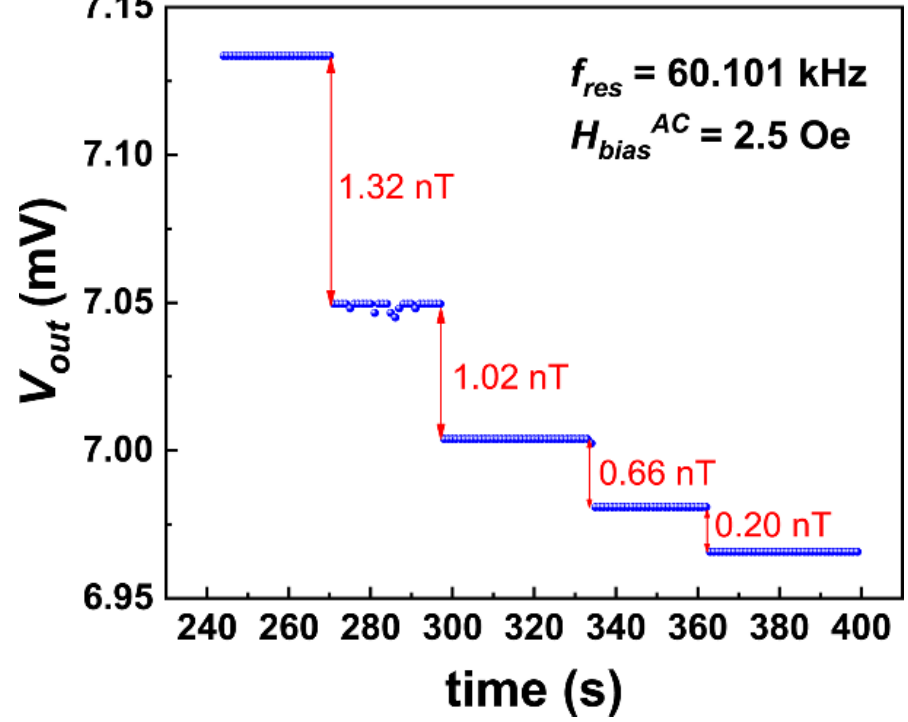
Figure 4. AC magnetic field resolution at 𝑓 𝑟𝑒𝑠 of 60.101 kHz and 𝐻 𝑏𝑖𝑎𝑠𝐴𝐶 of 2.5 Oe. Similarly, DC field resolution 𝐻 𝑟𝑠𝑙𝐷𝐶 can be obtained using a DC bias field perturba- tion (DBFP) method considering the working points of 𝑓 Oe [8], as shown in Figure 5. The red dotted line represents output voltage 𝑉 sensor operating at the above working points without the DC perturbation magnetic field ((𝑉 𝑜𝑢𝑡 ) 0 ), which can be used as a reference voltage without input DC magnetic field. The optimal DC bias field 𝐻 𝑏𝑖𝑎𝑠 𝐷𝐶 = 0.5 Oe was supplied by the Helmholtz coils. The DC field to be measured, 𝐻 𝑡𝑏𝑚𝐷𝐶 , which has an opposite direction with respect to 𝐻 𝑏𝑖𝑎𝑠𝐷𝐶 , was gener- ated by the small solenoid, supplied by a Keithley 2400 source meter. If 𝐻 𝑡𝑏𝑚𝐷𝐶 (for exam- ple, 5.0 nT) was exerted on the ME sensor, the 𝑉 𝑜𝑢𝑡 (time) step decreased from 5.97 mV to 2.91 mV (Figure 5). If DC input field 𝐻 𝑡𝑏𝑚𝐷𝐶 was removed, 𝑉 𝑜𝑢𝑡 was recovered to its origi- nal value. By gradually reducing the 𝐻 𝑡𝑏𝑚𝐷𝐶 value till the 𝑉 𝑜𝑢𝑡 (time) step cannot be distin- guished from the base line, DC magnetic field resolution 𝐻 𝑟𝑠𝑙 𝐷𝐶 can be obtained. As illus- trated in Figure 5, a very low 𝐻 𝑟𝑠𝑙𝐷𝐶 of 0.34 nT was achieved in this study.